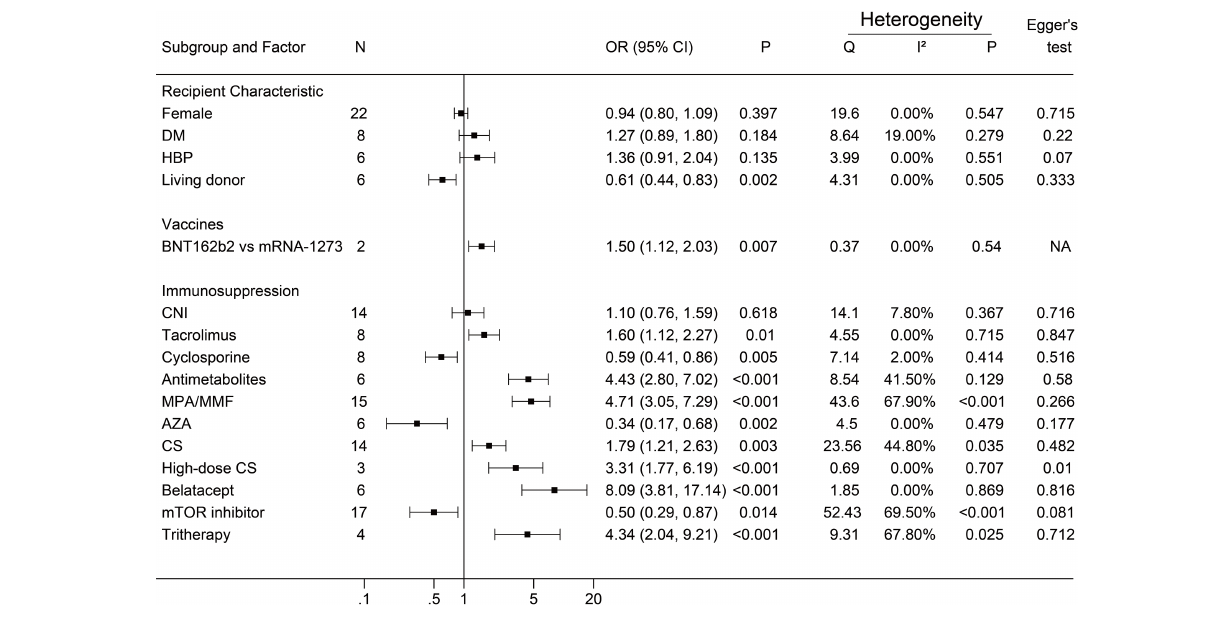
FIGURE 2 | Forest plots of dichotomous factors. The event was a negative antibody response after vaccination. N, The number of studies; DM, diabetes mellitus; HBP, hypertension; CNI, calcineurin inhibitor; MPA/MMF, mycophenolic acid or mycophenolate mofetil; AZA, azathioprine; CS, low-dose corticosteroids; mTOR inhibitor, mammalian target of rapamycin inhibitor; Tritherapy, triple immunosuppressive therapy. NA indicates missing Egger's